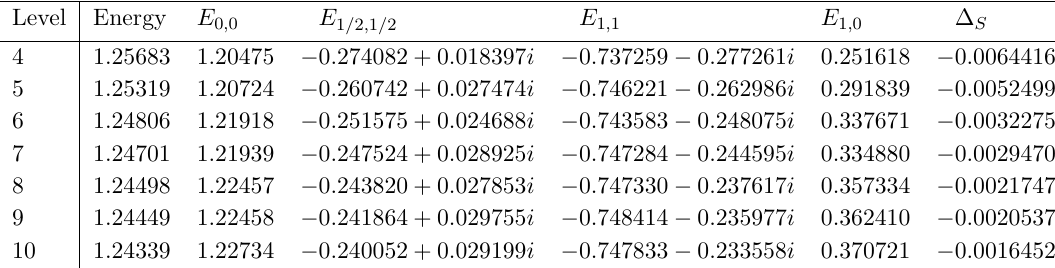
Table 25 . Selected observables of exotic solution number 6534 in the k = 8 model with J = 2 boundary conditions.